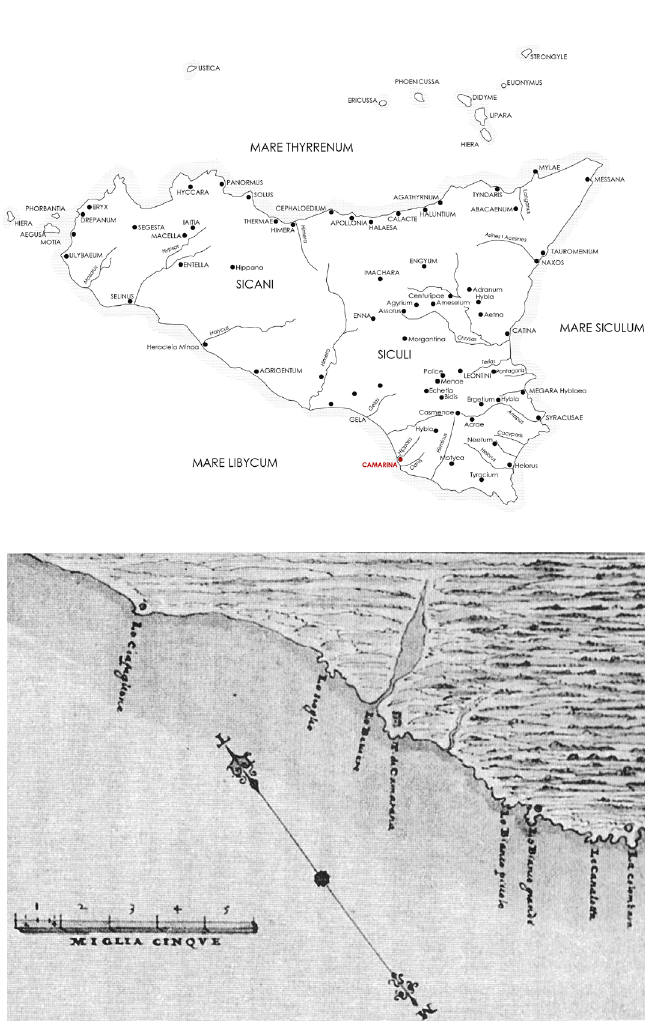
Fig. 8 The territory of Kamarina in Greek Sicily.